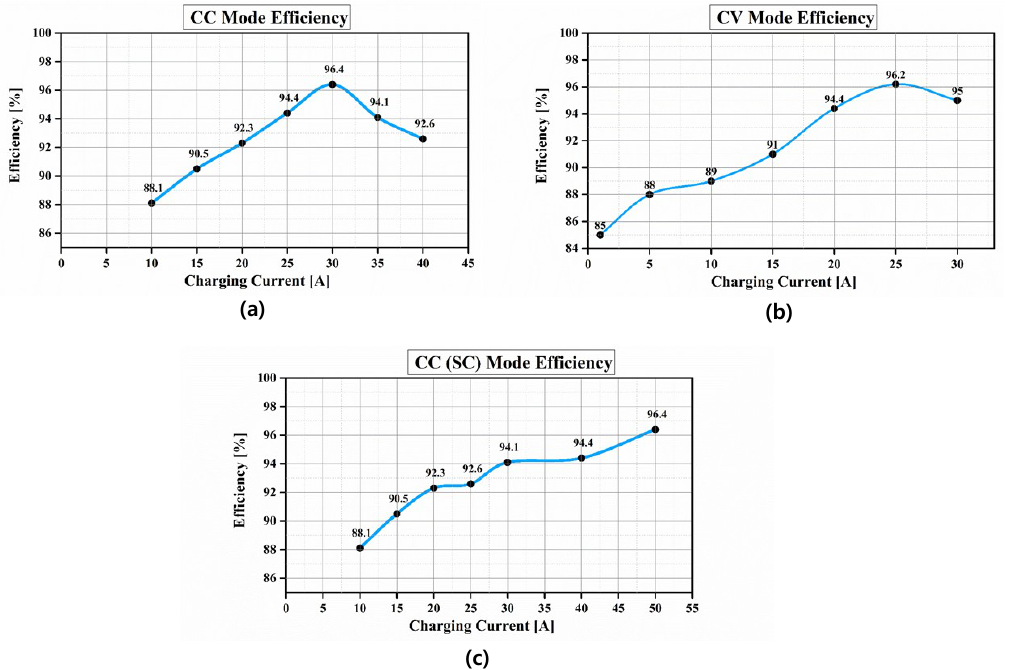
Figure 16. The efficiency based on the charging current: ( a ) the CC Mode (LI); ( b ) the CV Mode (LI); ( c ) the CC Mode (SC).